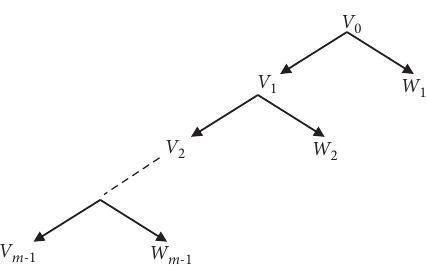
Figure 3: Orthogonal wavelet analysis.